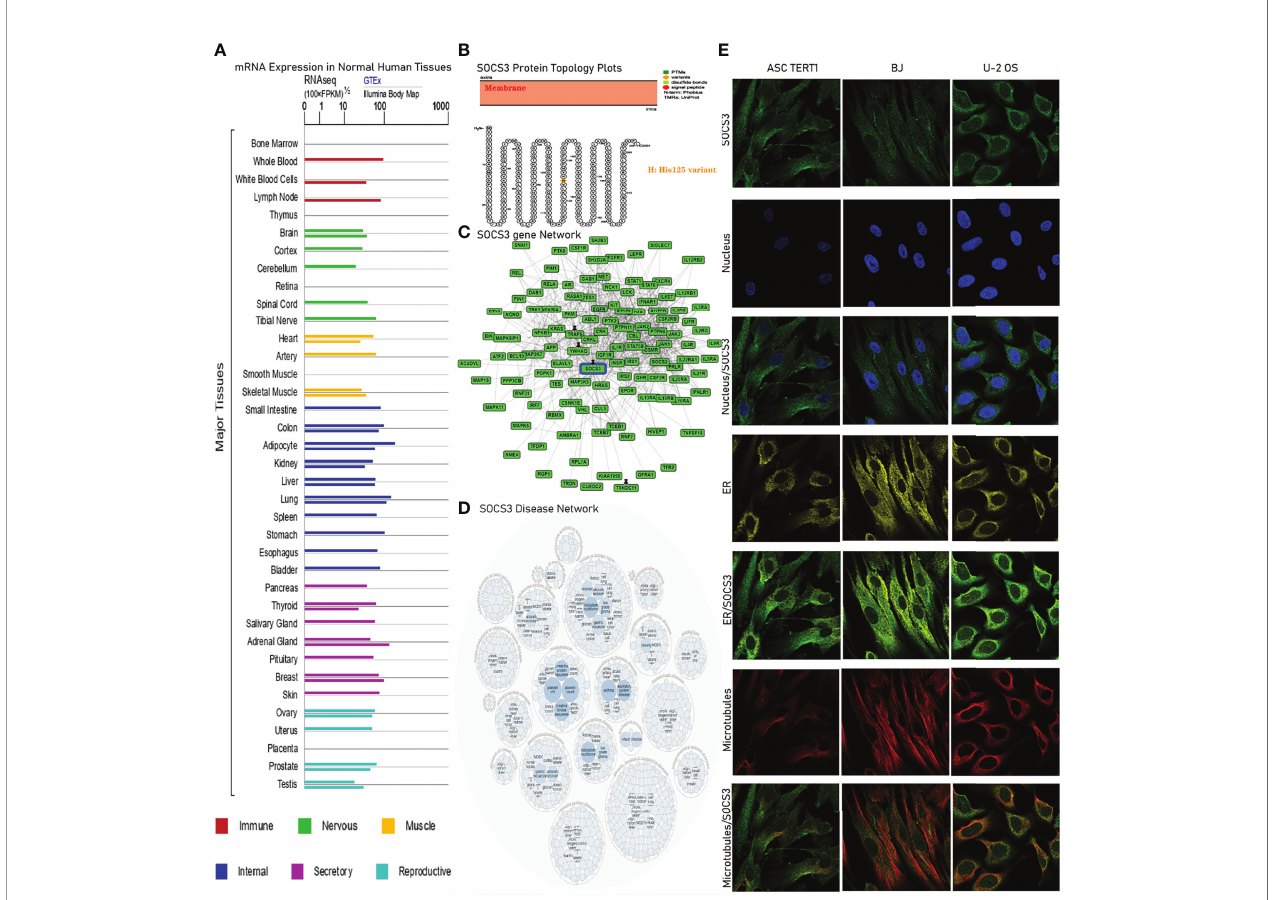
FIGURE 2 | S OCS3 localization, variations, and expression under physiological conditions. (A) SOCS3 mRNA expression status in disparate normal human samples across GTEx database. (B) SOCS3 protein topology shows a His125 variant that is located in the membrane. (C, D) Network of functional genes and diseases associated with SOCS3 . (E) Immuno fl uorescence staining of subcellular distribution of SOCS3 in endoplasmic reticulum (ER), nucleus and microtubule of ASC TERT1, BJ, and U-2